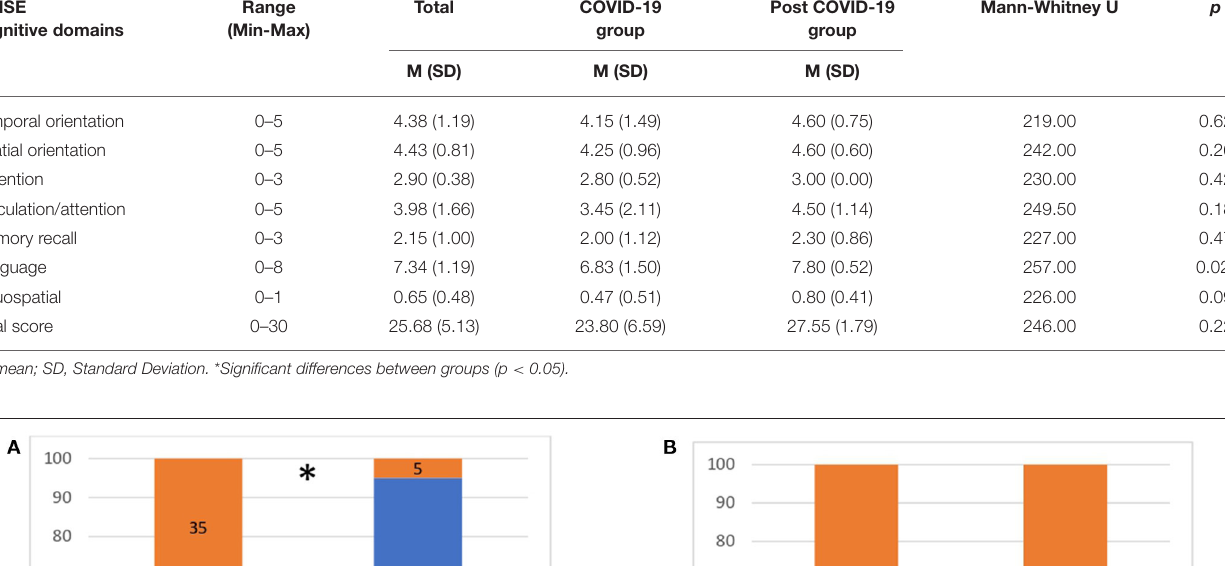
TABLE 2 | Comparison of MMSE subtests between COVID-19 and Post-COVID-19 groups. MMSE cognitive domains